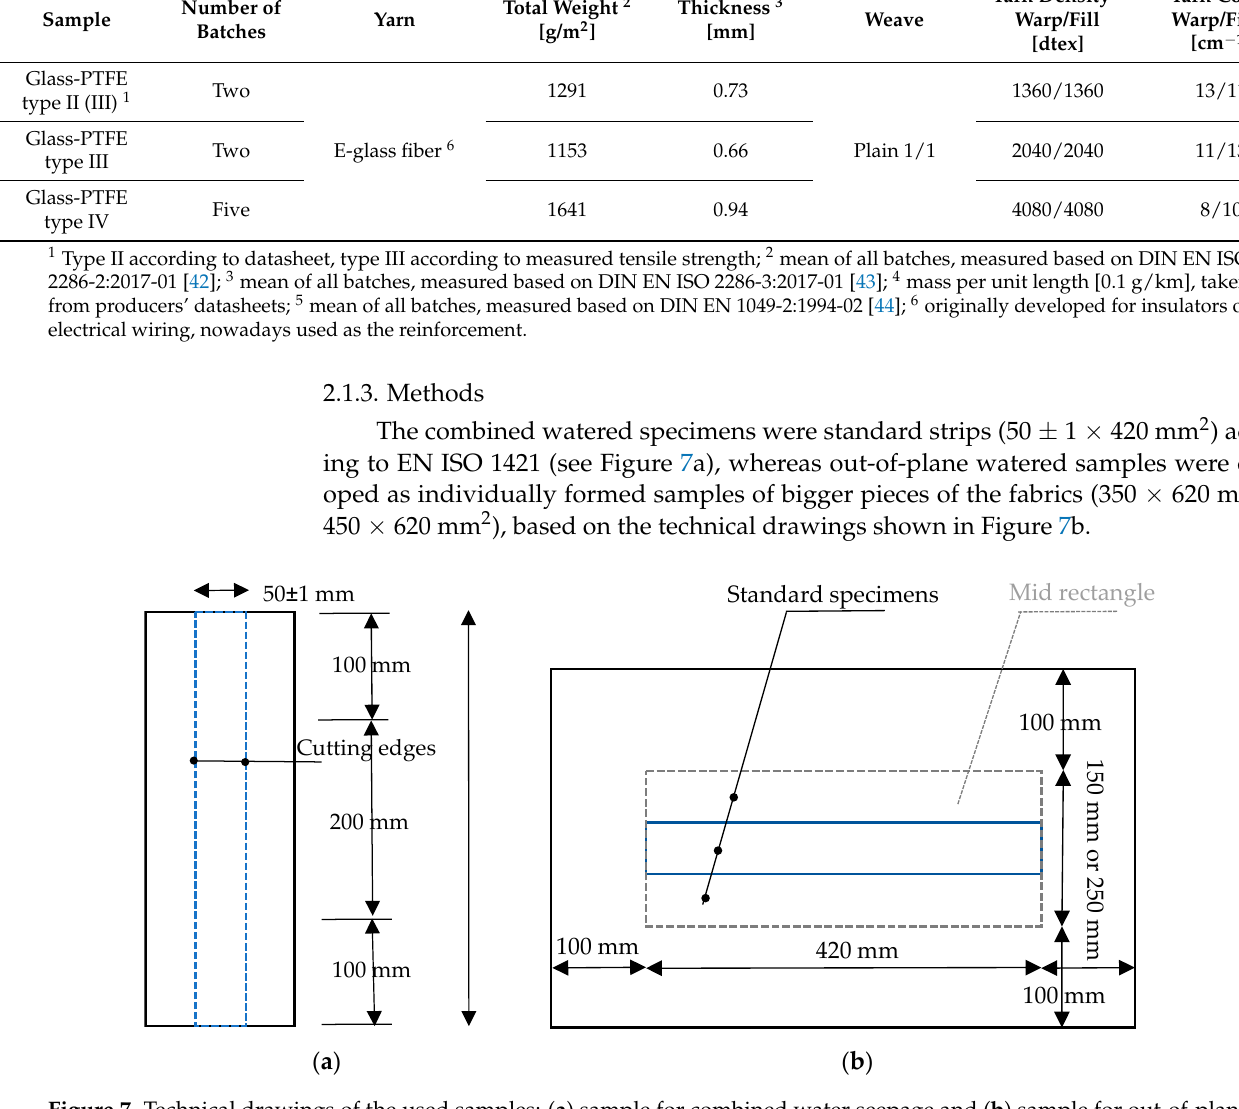
Figure 7. Technical drawings of the used samples: ( a ) sample for combined water seepage and ( b ) sample for out-of-plane water seepage.